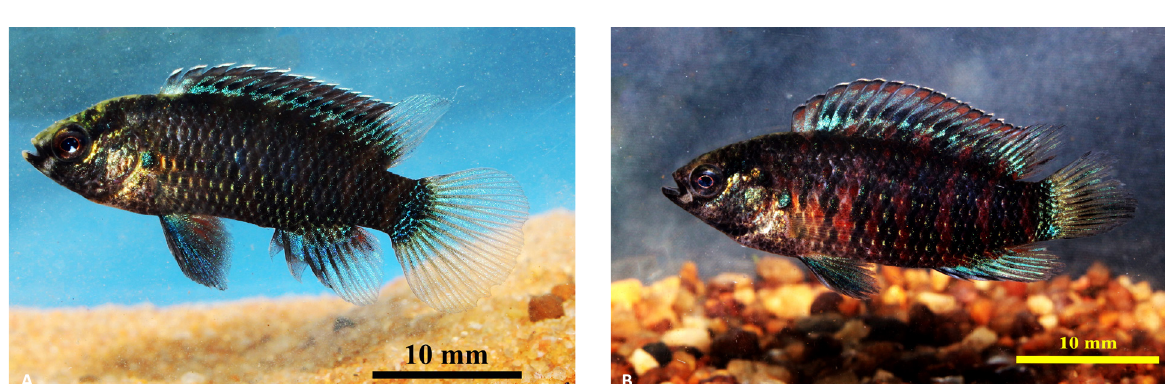
Figure 1. Distribution of Badis badis in Godavari basin of Telangana State, India